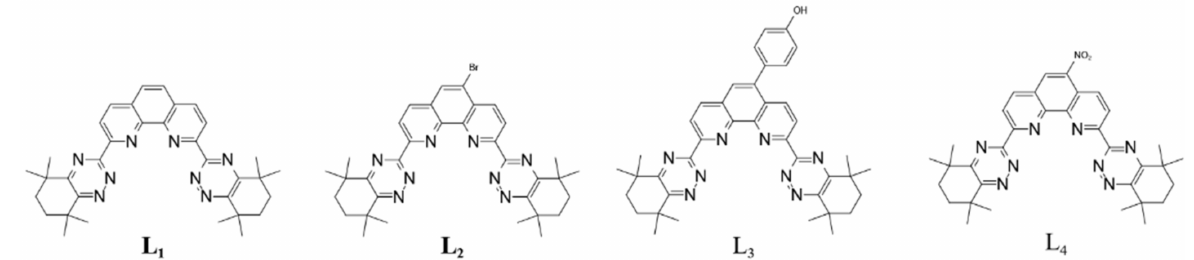
Figure 1. Structures of four Bis-Triazine